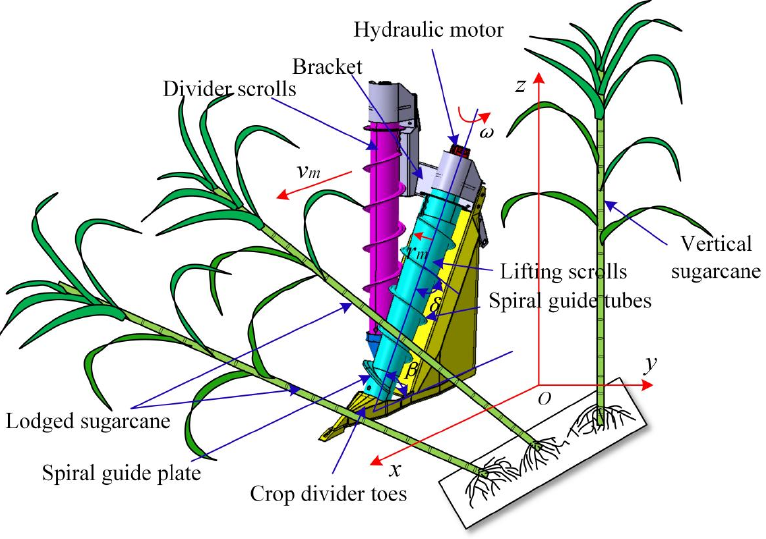
Figure 2. Sugarcane harvester component parts.